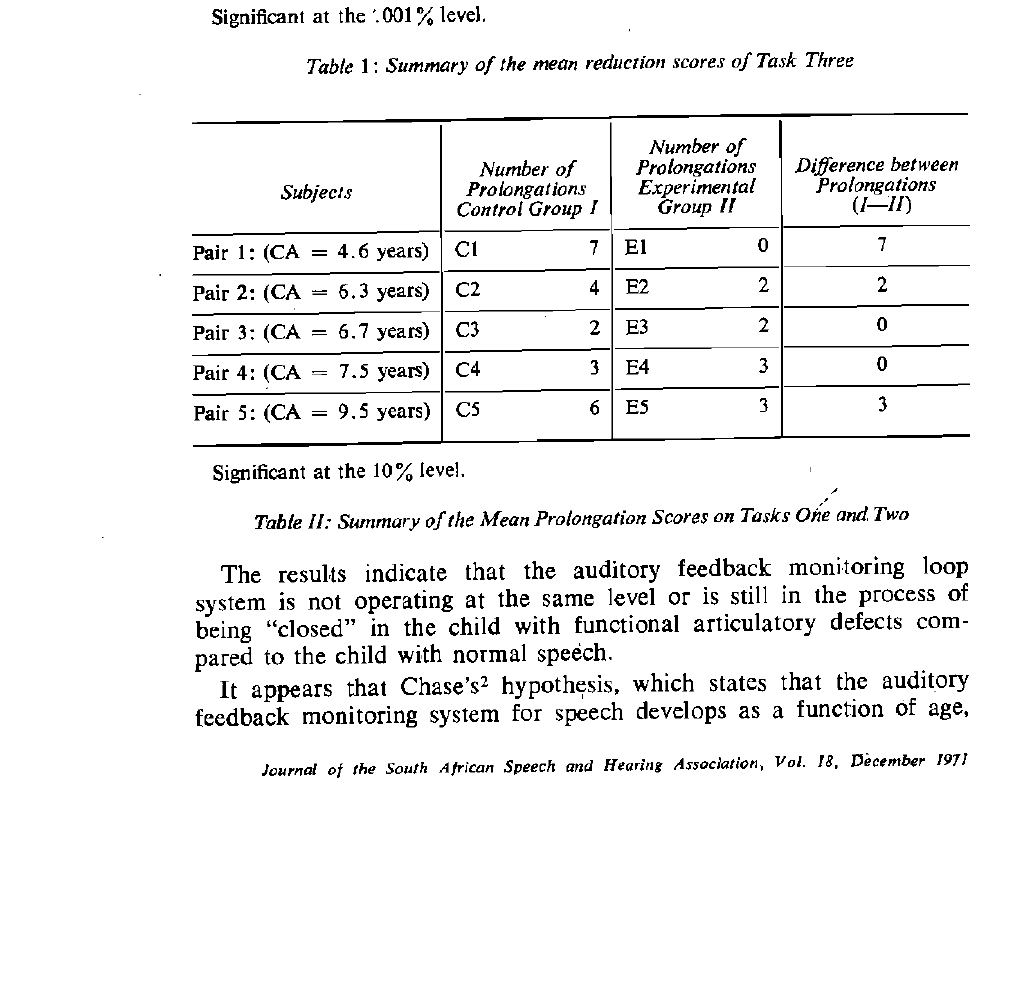
Table 1 : Summary of the mean reduction scores of Task Three